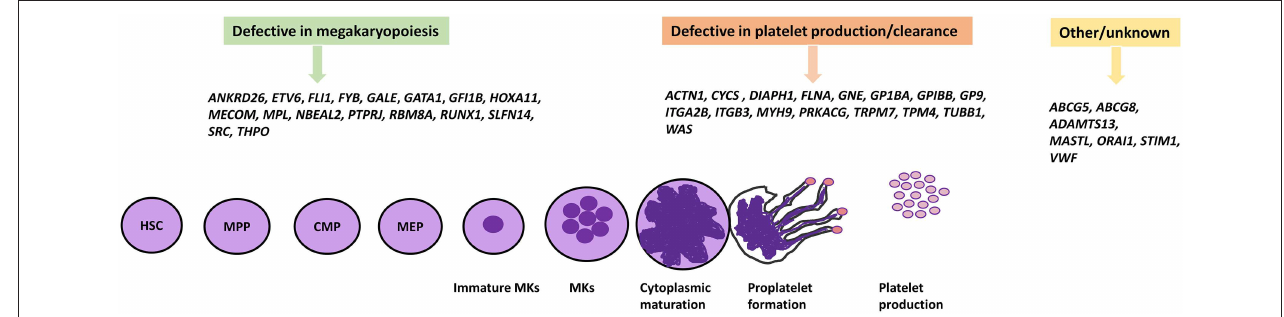
FIGURE 1 | IT causative genes involved in megakaryopoiesis, platelet formation, and others. The differentiation of platelets from HSCs proceeds by multiple different cell lineages which involve many genes encoding a number of transcription factors and proteins. Genetic defects in these genes have been shown to cause IT. HSC,